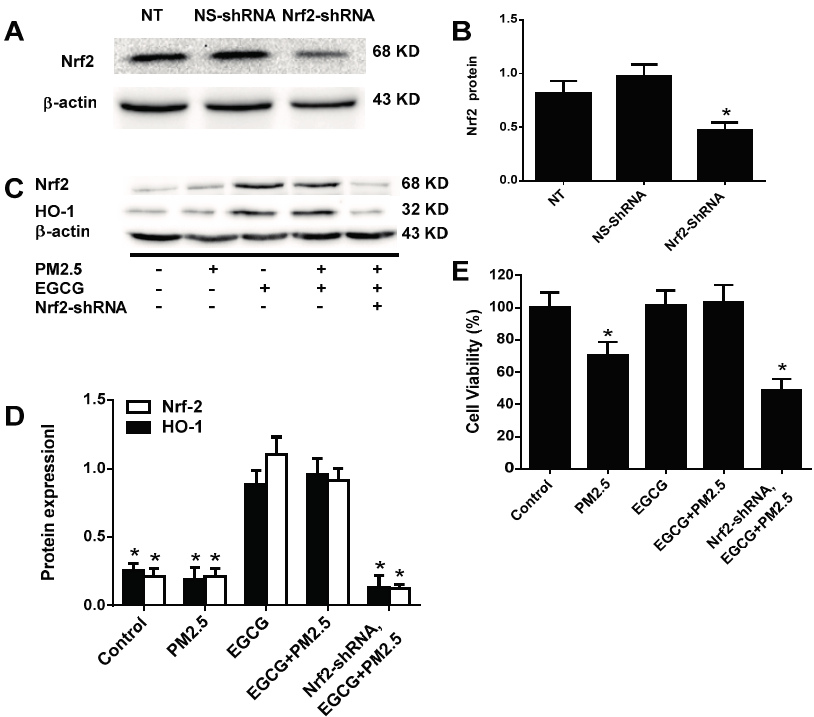
Figure 7. Nrf2 silencing abolished EGCG-induced Nrf2 and HO-1 upregulation in PM 2.5 -treated HUVECs. Nrf2 was silenced by transfecting HUVECs at 60%–70% confluence with Nrf2-shRNA (100 nM, Nrf2-shRNA) for 24 h. NS-shRNA, HUVECs transfected with a nonspecific shRNA (100 nM, Nrf2-shRNA-nonsilencing control); NT, non-transfected control HUVECs. ( A ) Western blotting demonstrating the efficiency of Nrf2 silencing using β -actin as a loading control. ( B ) Pooled data from A are expressed as the means ± SEM of three independent experiments. * p < 0.05 vs. NS-shRNA. ( C ) Representative images of Nrf2 and HO-1 protein expression in HUVECs treated as indicated. ( D ) Pooled data from C are expressed as the means ± SEM of three independent experiments. * p < 0.05 vs. EGCG+PM 2.5 . ( E ) Cell viabilities in HUVECs treated as indicated are expressed as the means ± SEM of six independent experiments. * p < 0.05 vs. EGCG+PM 2.5